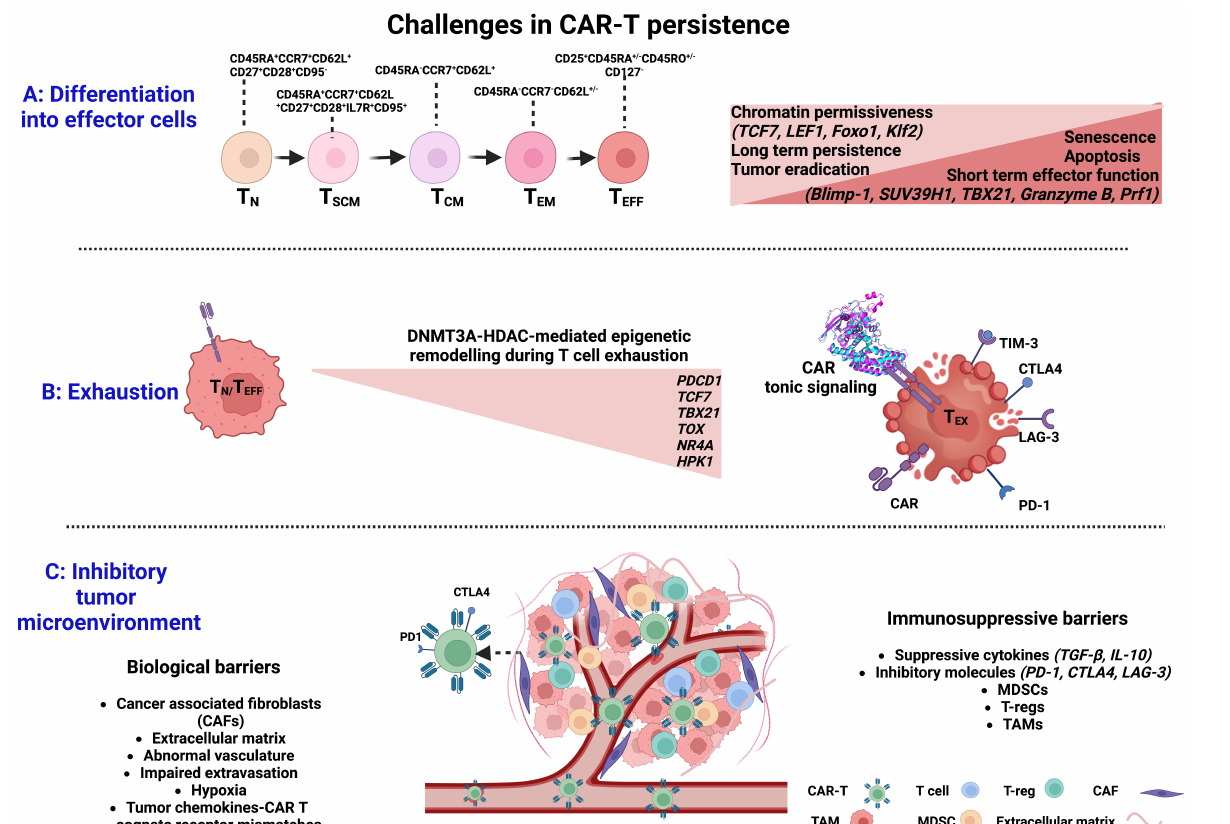
Figure 2. Significant barriers limiting CAR-T cell efficacy and their complex interplay with epigenetic regulation. ( A ) Differentiation into effector cells is associated with acquisition of repressive methylation marks at naïve cell-associated genes and demethylation marks at defined effector molecules. ( B ). The effector-to-exhaustion transition of T cells is DNMT3A- and HDAC-mediated and characterized by the sustained expression of several inhibitory receptors ( PD-1 , CTLA-4 , LAG3 , and TIM3). Exhaustion may be induced by antigen-independent receptor signaling and dimerization, resulting in aggregation of CARs and auto-activation ( tonic signaling ). ( C ). The many biological and immuno-suppressive barriers within the tumor constitute a complex and hostile tumor microenvironment, allowing uncontrolled proliferation and immune escape of cancer cells, preventing CAR-T cell infiltration, and driving CAR-T cell dysfunction to ultimately inhibit the efficacy of T-cell immunotherapies ( CAF: cancer-associated fibroblast ; TAM: tumor-associated macrophage ; MDSCs: myeloid-derived suppressor cells ; Tregs: regulatory T cells) Created with